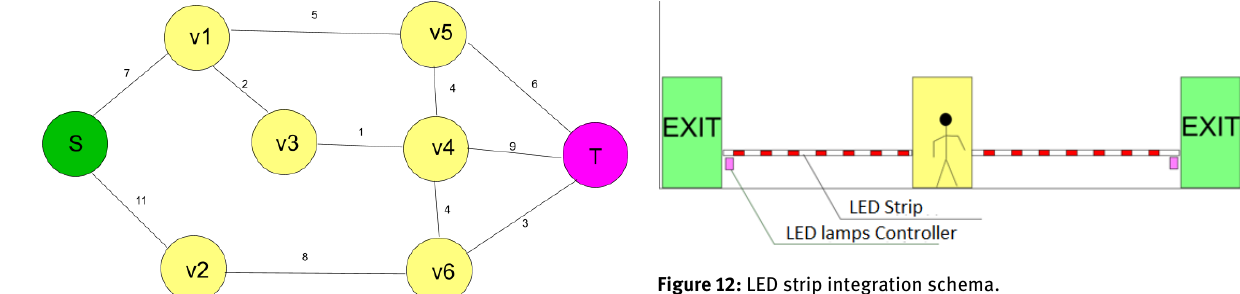
Figure 12: LED strip integration schema.